Question: Produce a descriptive caption suitable for publication.
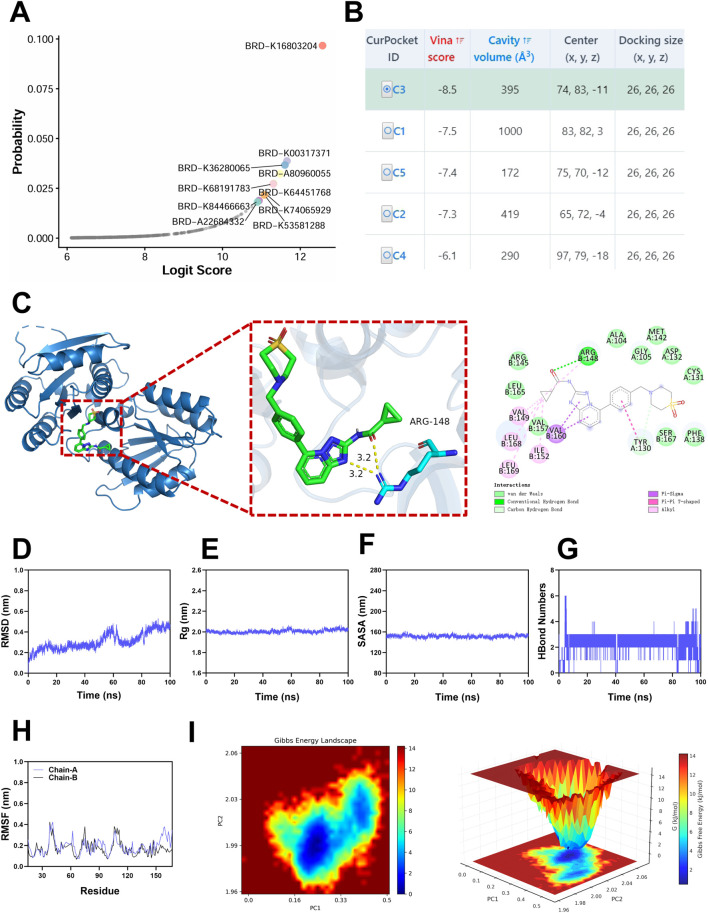
Answer: Drug repositioning, molecular docking, and molecular dynamics simulation of CENPM (A) DrugReflector screening identifies filgotinib as the top candidate (B) Docking poses in pockets C1–C5; optimal binding in C3 (Vina score = −8.5 kcal/mol) (C) Interaction diagram of filgotinib in pocket C3 (D–I) MD simulation analyses (D) RMSD, (E) Rg (F) SASA, (G) H-bond count (H) RMSF, and (I) free energy landscape.